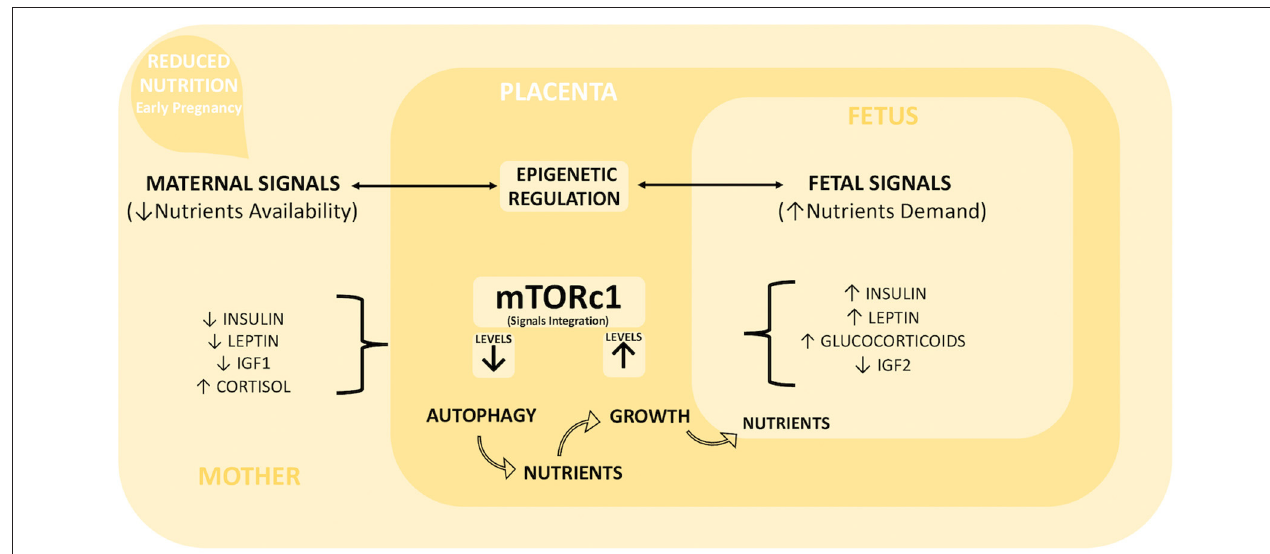
FIGURE 2 | Placental integration of foeto-maternal signals. Maternal undernutrition during early pregnancy generates a series of maternal and fetal signals of adversity, whose integration is one of the key functions of the placenta. Maternal signals include low levels of insulin, leptin, and IGF1 and high levels of cortisol, while fetal signals include high levels of insulin, leptin, glucocorticoids, and low levels of IGF2. These signals are integrated by mTORc1 placental signaling. We hypothesized that moderate maternal undernutrition decreases mTORc1 levels, which in turn activate the intracellular degradation mechanism of autophagy. The degradation products can be used as new nutrients to counterbalance inadequate maternal support. This short-term increased availability of nutrients can increase mTORc1 levels and consequently enhance placental growth and nutrient transport capacity toward the developing fetus. Furthermore, the epigenetic regulation of placental gene expression (in particular on imprinted genes) plays a fundamental role for a balanced resources distribution between mother and fetus, so it could be particularly important for driving placental adaptation in the case of reduced maternal